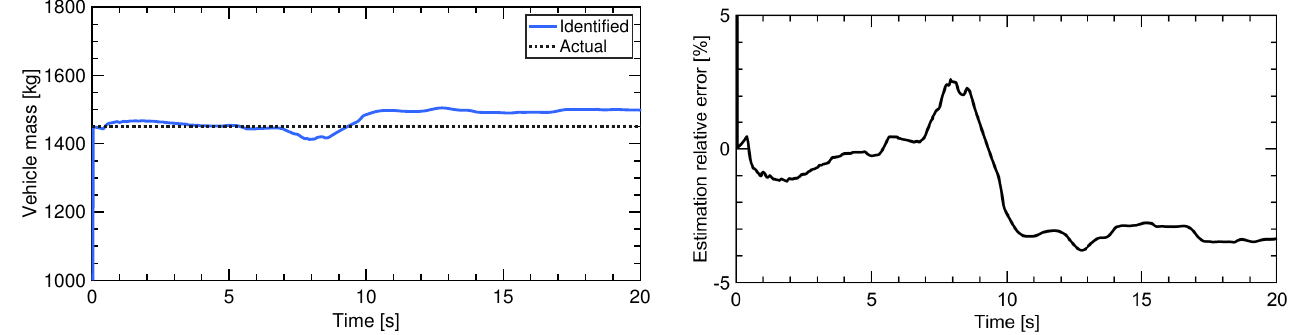
Figure 28. Identification of mass: identified value ( left ) and relative error ( right ).